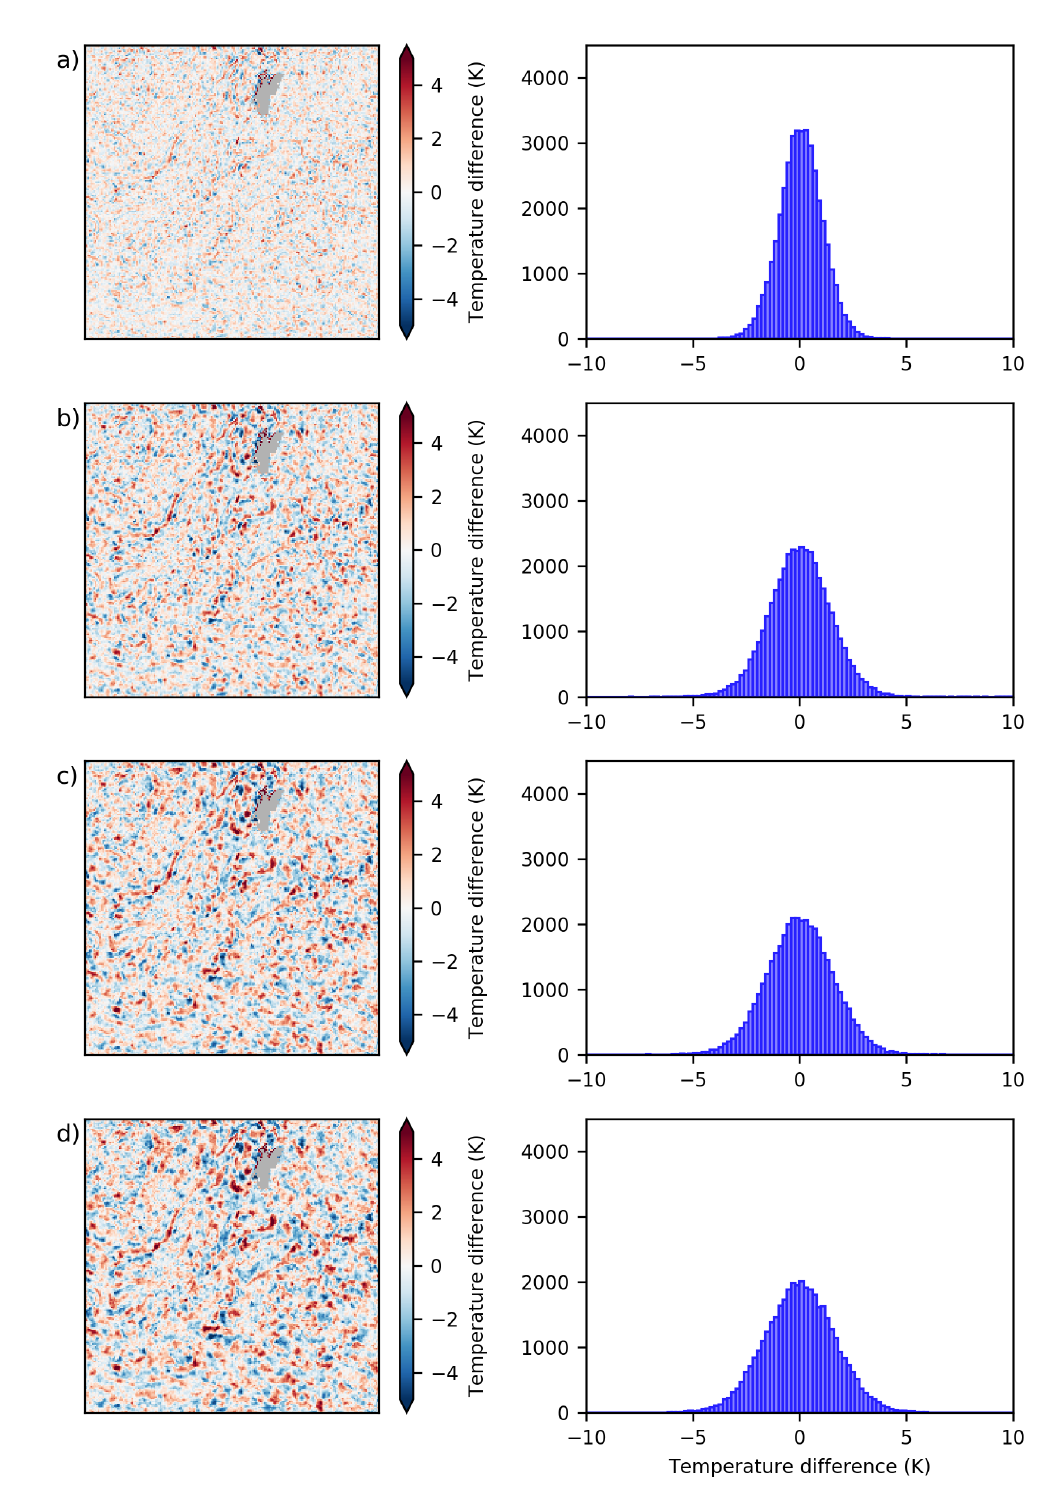
Figure A4. Changes in the spatial and statistical distribution of temperature estimates for the north-western Australia (nwa) study area by window size. Window levels shown are ( a ) 5 × 5 window; ( b ) 7 × 7 window; ( c ) 9 × 9 window; and ( d ) 11 × 11